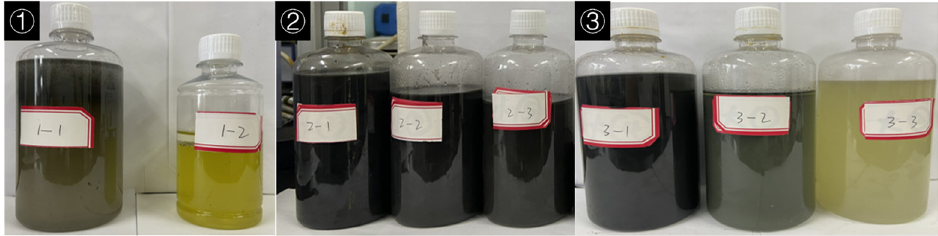
Figure 11. The water samples flowback liquids of three times descaling (1-1: The initial flowback water sample when the downhole fluid began to flow out from the wellhead for the first round descaling; 1-2: Subsequent non-scale flowback water sample for the first round descaling; 2-1: The initial flowback water sample when the downhole fluid began to flow out from the wellhead for the second round descaling; 2-2: The water sample when the volume of flowback fluid was about 300 L for the second round descaling; 2-3: The water sample when the volume of flowback fluid was about 600 L for the second round descaling; 3-1: The initial flowback water sample when the downhole fluid began to flow out from the wellhead for the third round descaling; 3-2: The water sample when the volume of flowback fluid was about 400 L for the third round descaling; 3-3: The water sample when the volume of flowback fluid was about 800 L for the third round descaling).